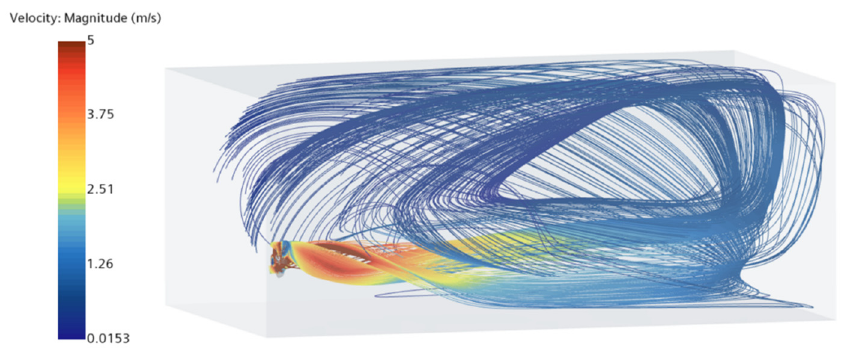
Figure 4. Velocity streamline diagram of full flow field.